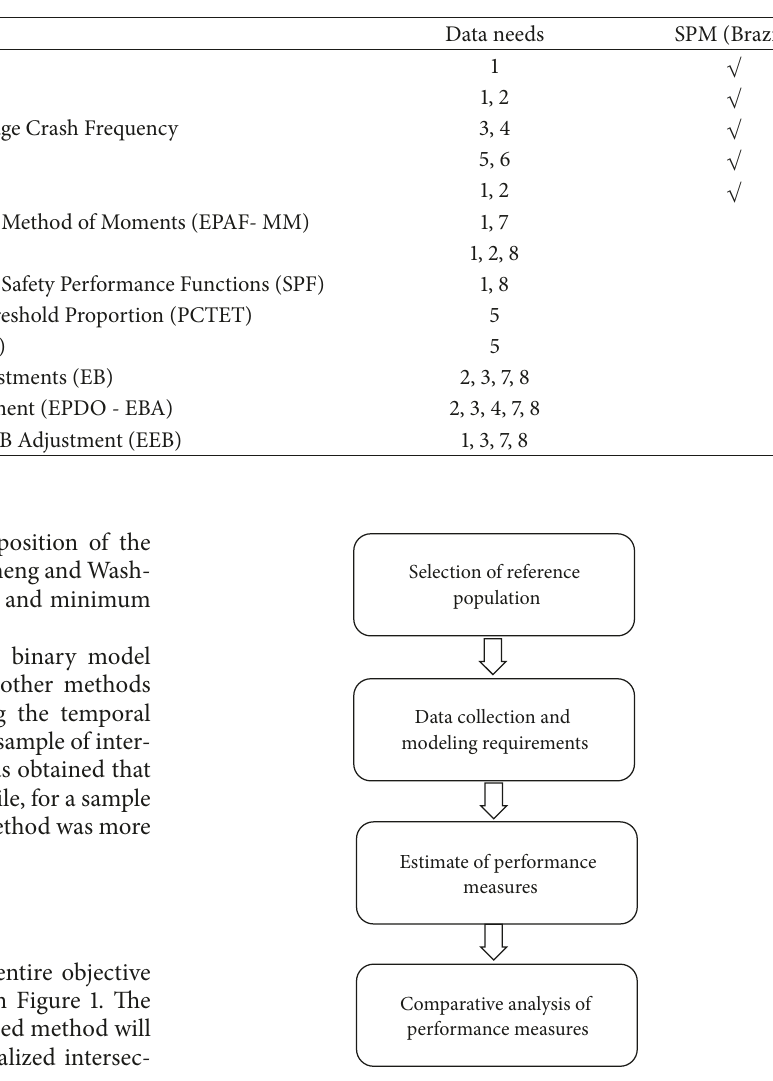
Table 1: HSM and SPM used in Brazilian safety manuals.